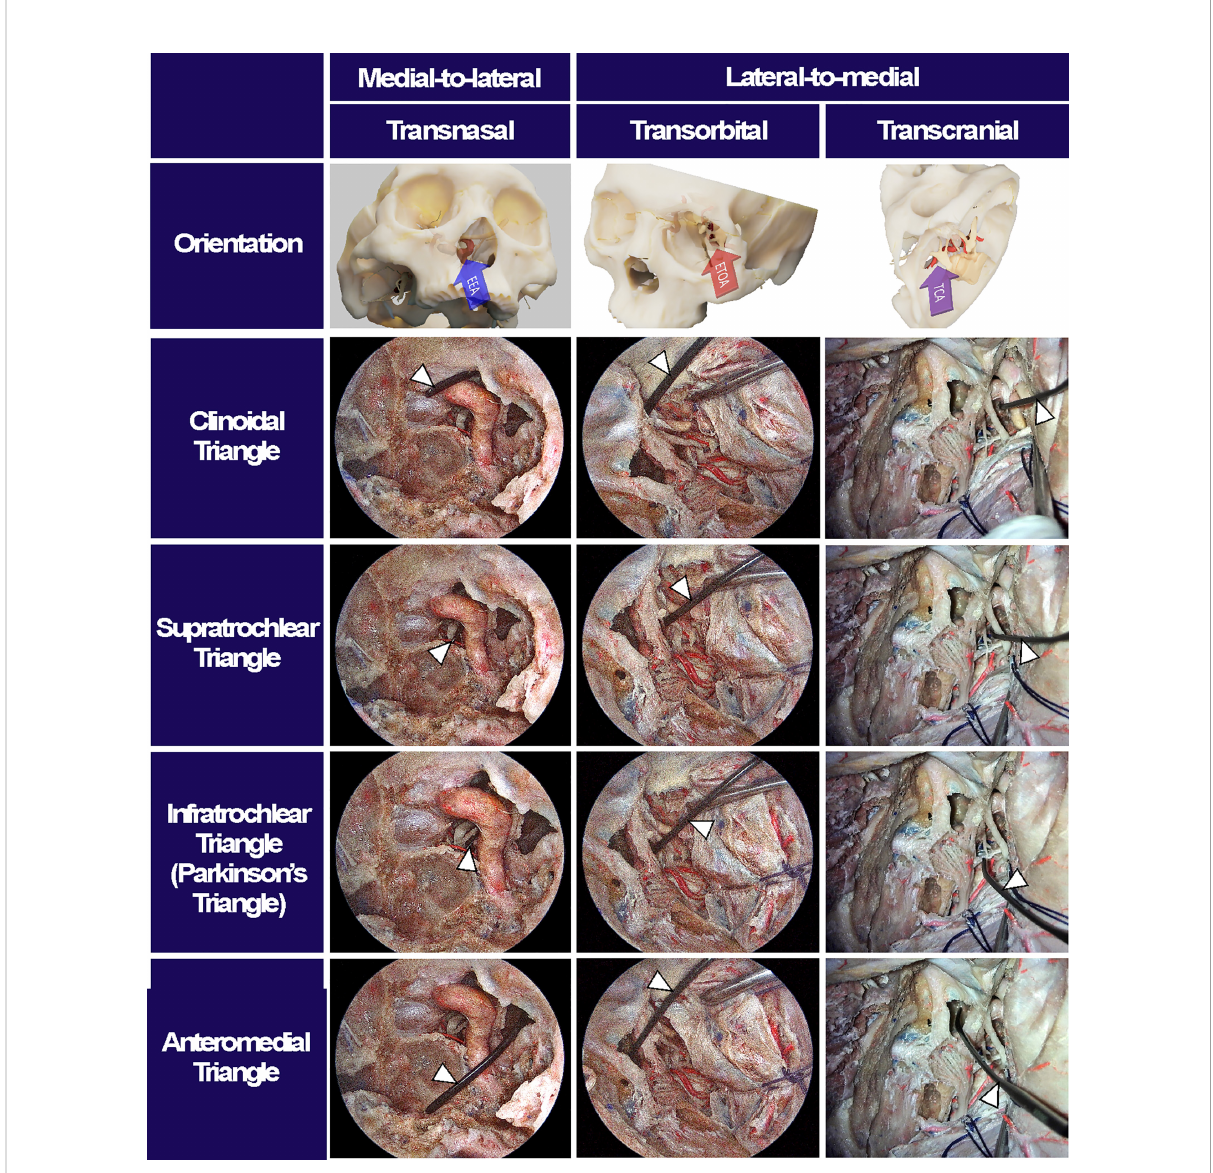
FIGURE 4 Surgical triangles of cavernous sinus with different approaches. Using a fresh cadaveric head, the surgical triangles to enter the cavernous sinus were simultaneously observed through an endoscopic endonasal approach (EEA), an endoscopic transorbital approach (ETOA), and a microscopic transcranial approach (TCA). The clinoidal triangle was made by removing the anterior clinoid process. The supratrochlear triangle consists of the oculomotor and trochlear nerves while the infratrochlear triangle, so called Parkinson ’ s triangle, was demarcated by trochlear nerve and ophthalmic branch of a trigeminal nerve. The anteromedial triangle indicated the space between the ophthalmic and maxillary branches of trigeminal nerve. After inserting an indicator (white arrowheads) into each triangle under TCA, the indicator ’ s location and angle were checked under EES and ETOA to enhance the understanding of surgical orientation in each